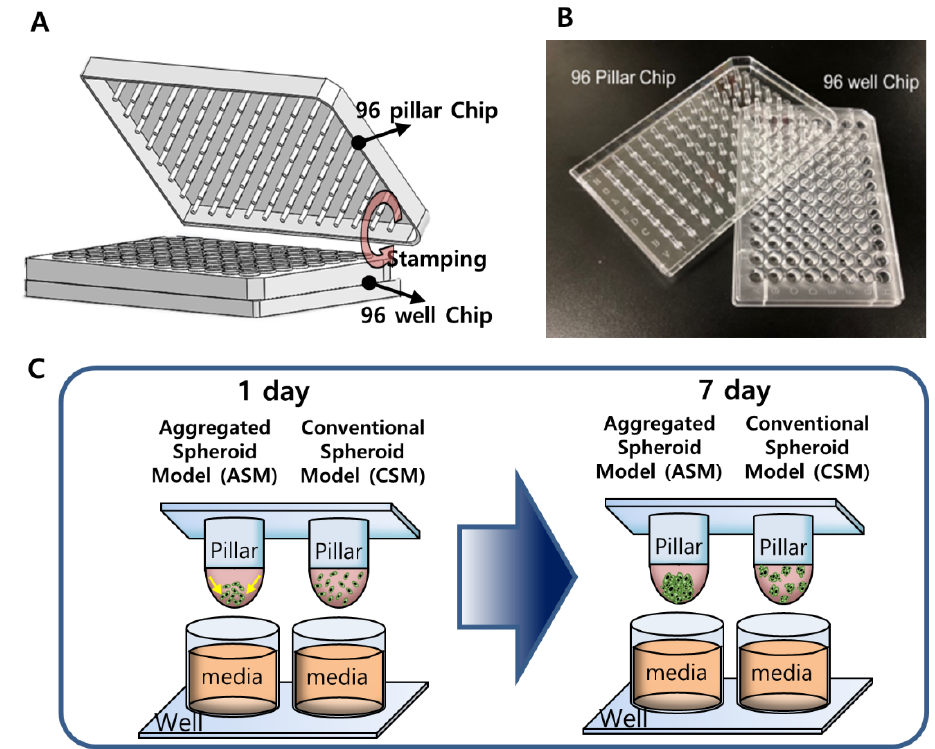
Figure 1. The 3D-HCC cells were cultured three-dimensionally with six different drugs in a 96-pillar/well plate (seven doses and three replicates). ( A ) Schematic view of the 96-pillar/well plate for the 3D-HCC cell-based HTS. ( B ) Image of fabricated 96-pillar/well plate. ( C ) Concept illustration of ASM compared to CSM.